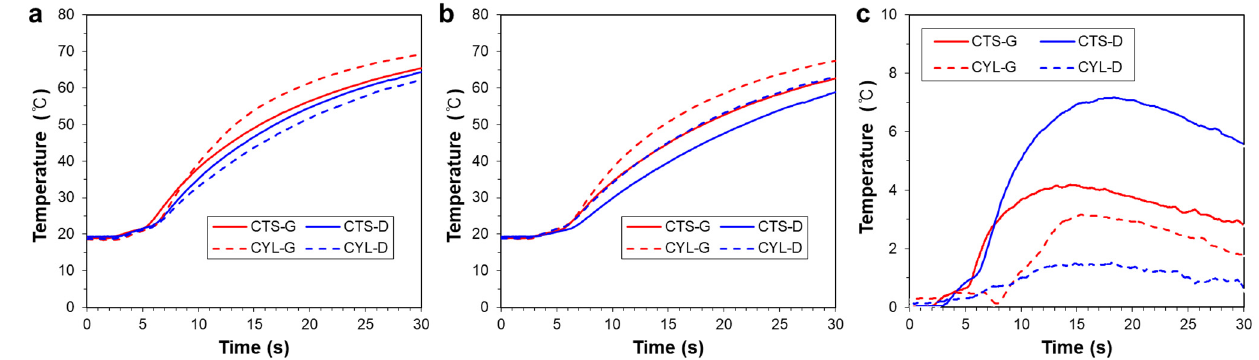
Figure 9. Temperature changes on the top surfaces for various TPMS shapes: ( a ) at Point 1 (P 1 ); ( b ) at Point 2 (P 2 ). ( c ) Temperature difference between P 1 and P 2 .